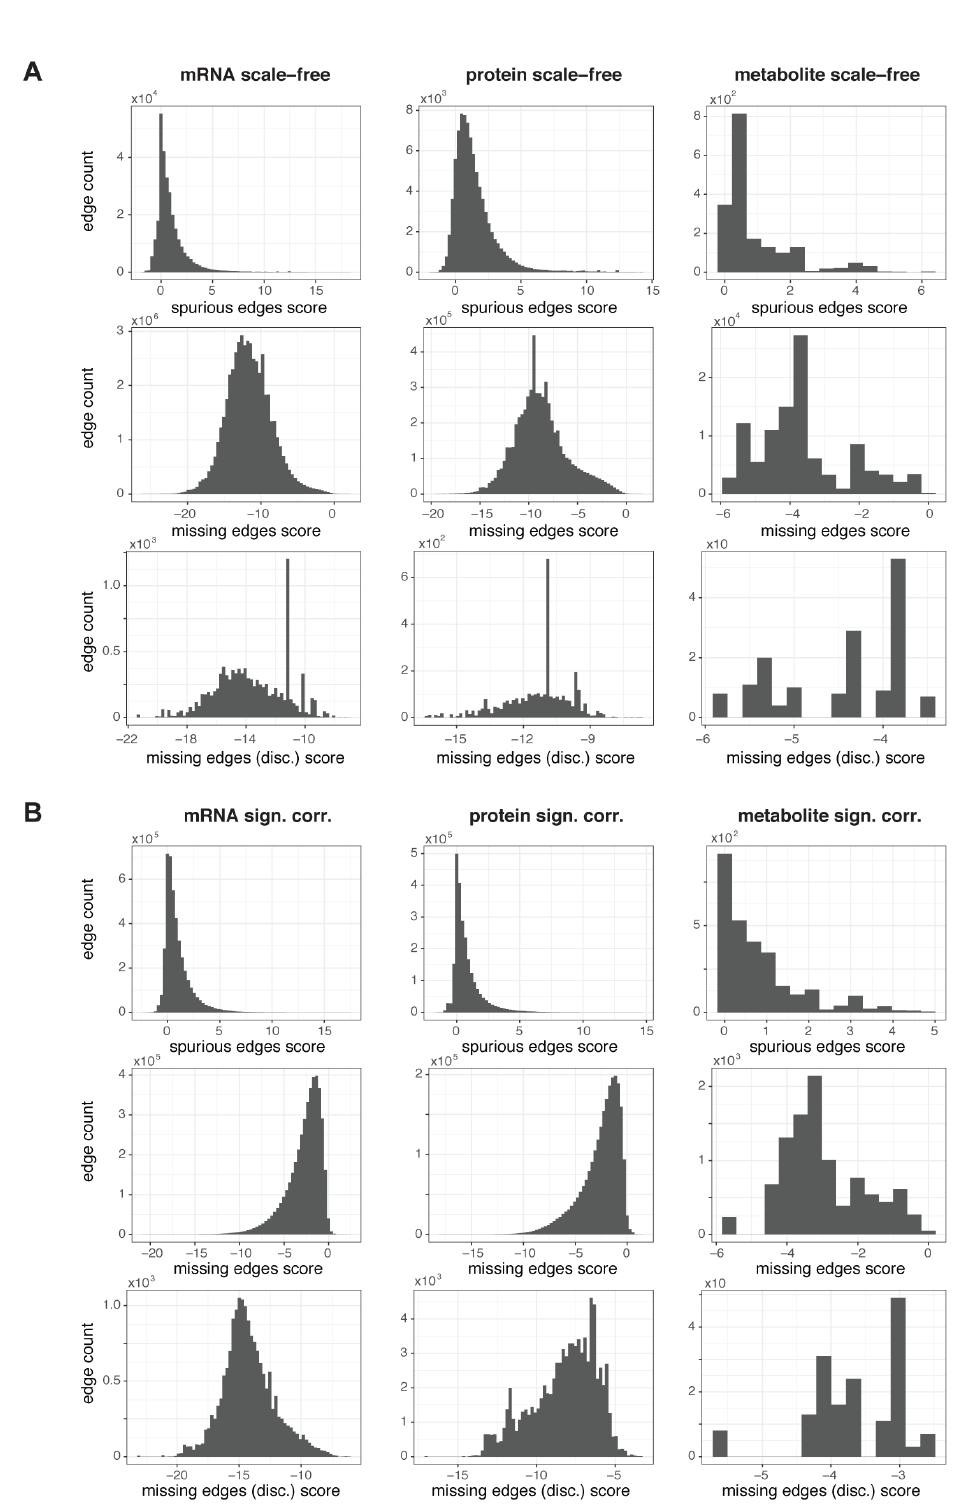
Figure 6. SBM-derived edge prediction: Missing and spurious edge confidence scores. ( A ) Histograms of edge confidence scores for the best fitting SBM of the three networks reduced by criterion on scale-freeness for all existing, i.e., putatively spurious edges (spurious edge score, top), for the putatively missing edges between nodes with degree > 0 (missing edge score, middle), for the putatively missing edges connecting a node of degree 0 to a node with a larger degree (missing edge (disc) score, bottom - only one edge for each node with degree > 0 is shown). ( B ) Edge confidence scores as described in ( A ) for the networks reduced by criterion on significance of correlation. For the mRNA and protein network, missing edge scores (middle) were only computed for the edges with largest absolute correlations of the node